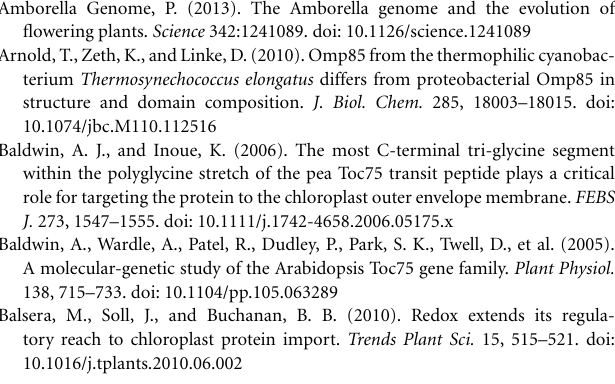
Table S1 | Sequences used for this study. Figure S1 | An alignment of sequences used for structure prediction and phylogenetic analysis. Figure S2 | Energy requirement for import of truncated chloroplast Omp85 homologs in vitro . REFERENCES Amborella Genome, P. (2013). The Amborella genome and the evolution of flowering plants. Science 342:1241089. doi: 10.1126/science.1241089 Arnold,T.,Zeth,K.,andLinke,D.(2010).Omp85fromthethermophiliccyanobac- terium Thermosynechococcus elongatus differs from proteobacterial Omp85 in structure and domain composition. J. Biol. Chem. 285, 18003–18015.